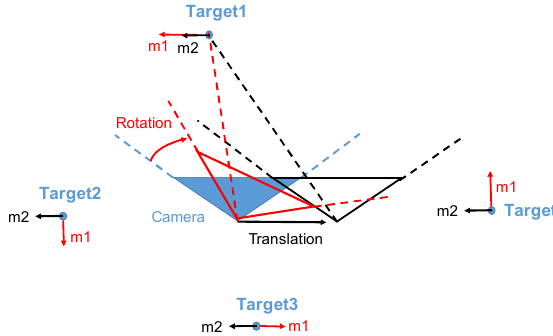
Figure 2. The translation of a limited-view camera along the horizontal axis and the horizontal rotation may result in the same movement for some features in images (Target 1); however, the same camera motion causes different movements for the features in other places (Target 2–4), only a full-view camera can capture them.